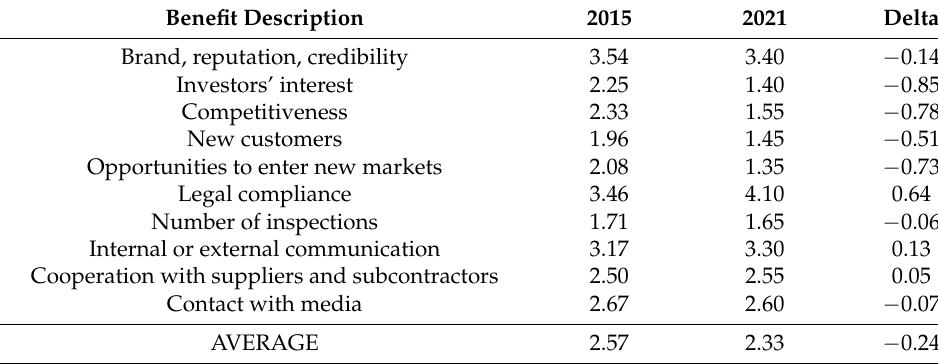
Table 4. Business management and marketing benefits of the EMAS.